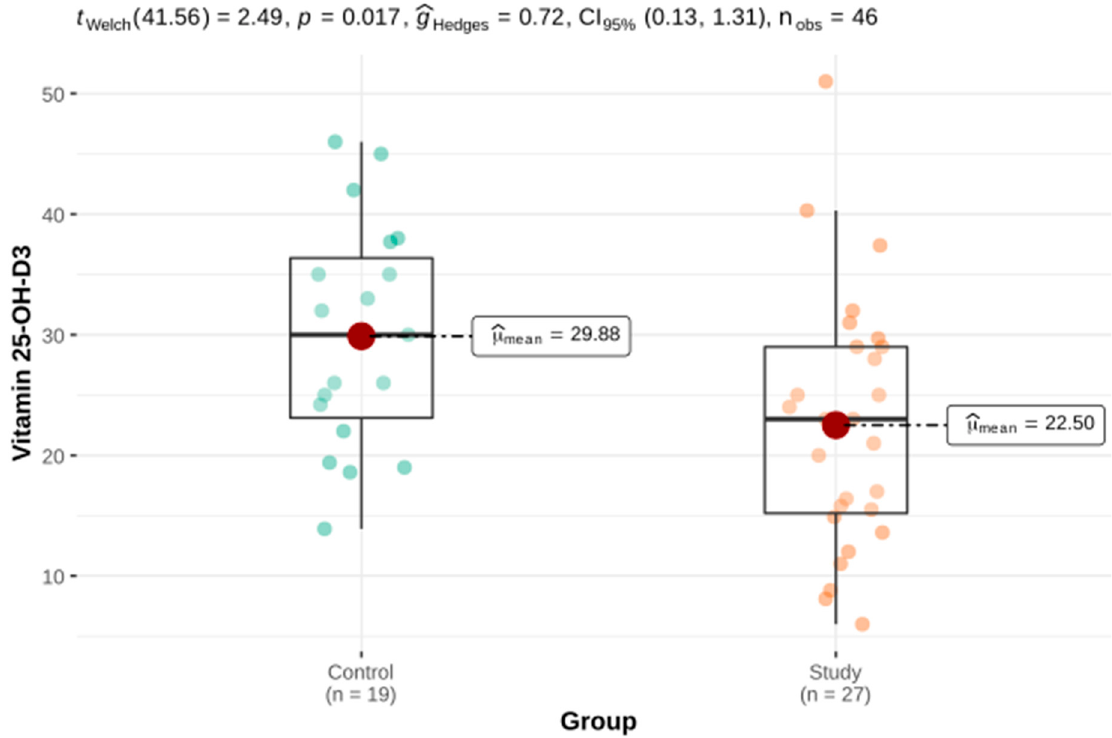
Figure 2. The serum vitamin 25-OH-D3 concentration in the study and the control groups.